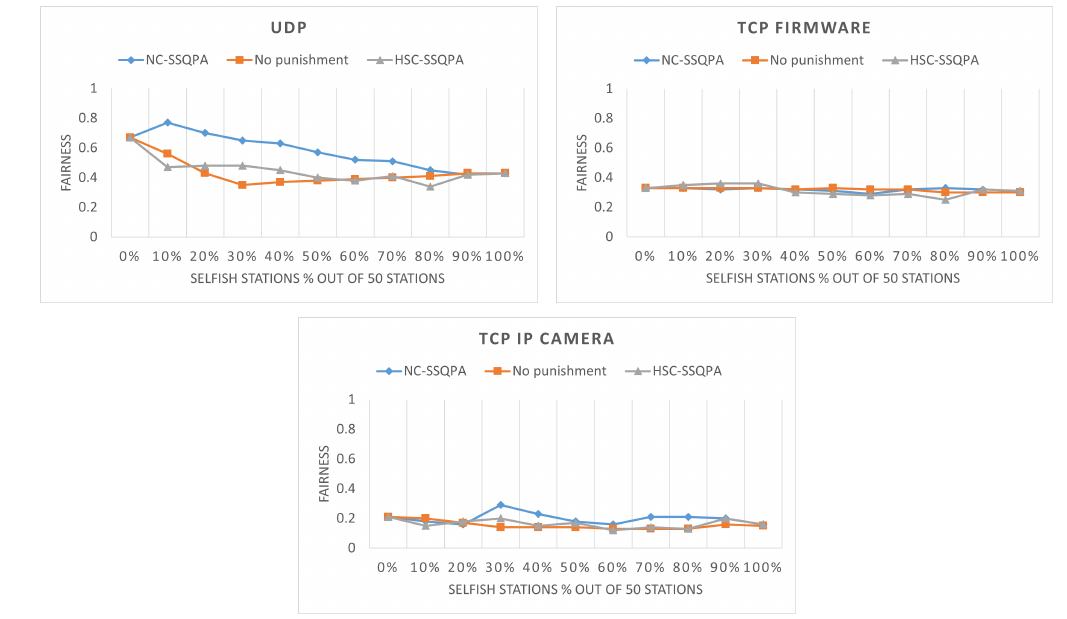
Figure 12. Network fairness comparison between both variants of SSQPA and no punishment.